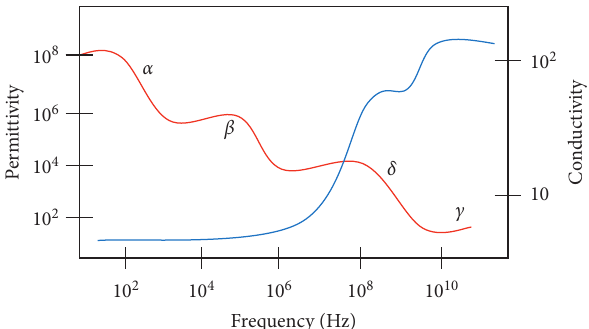
Figure 2: Permittivity and conductivity over the frequency spectrum, depicting the α , β , c , and δ